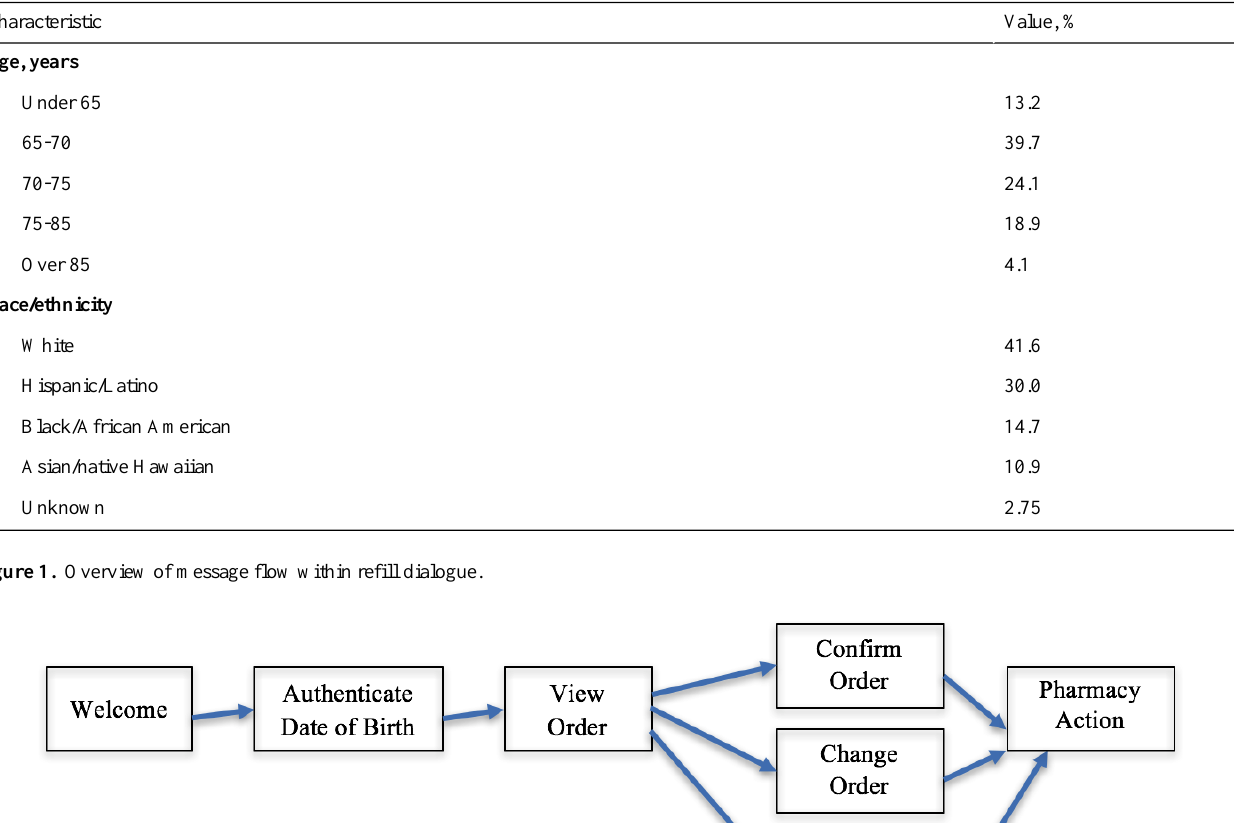
Table 1. Characteristics of text messaging group.